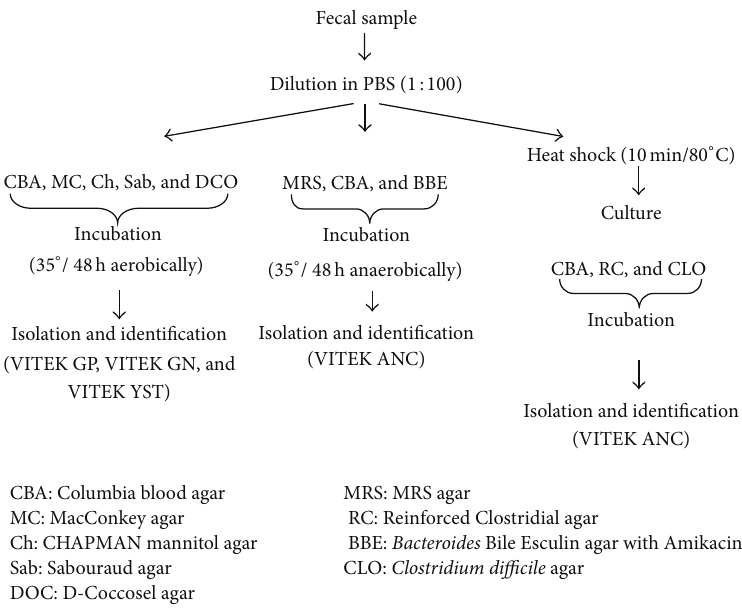
Figure 1: Fecal samples processing